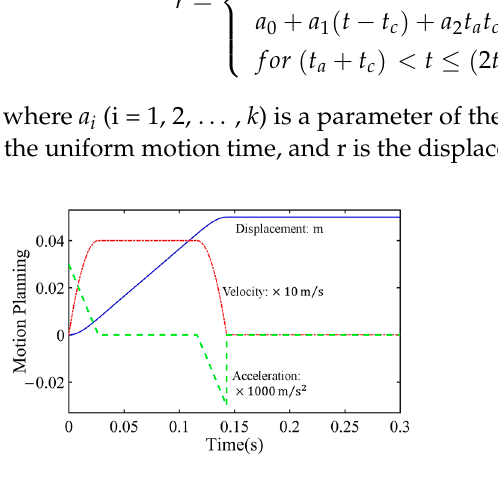
Figure 8. Diagram of the friction compensation voltage.